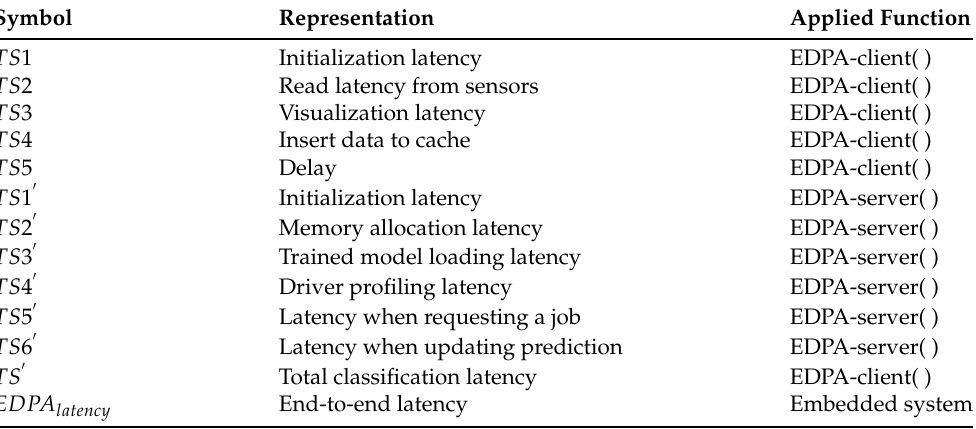
Table 1. Parameter notations.